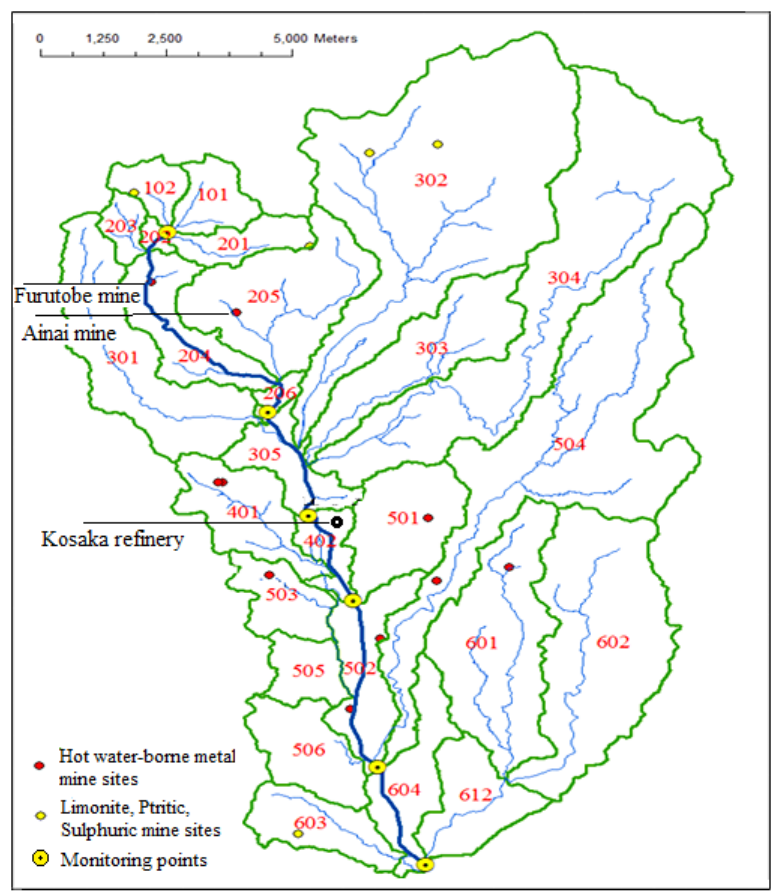
Figure 2. Sub-watershed division of the study area and historical mine site locations.